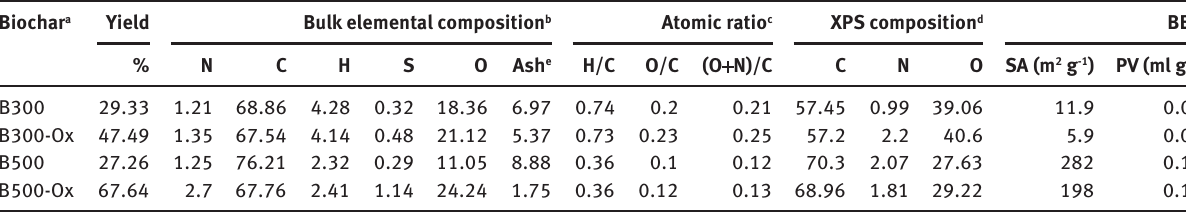
Table 2: Characterization of